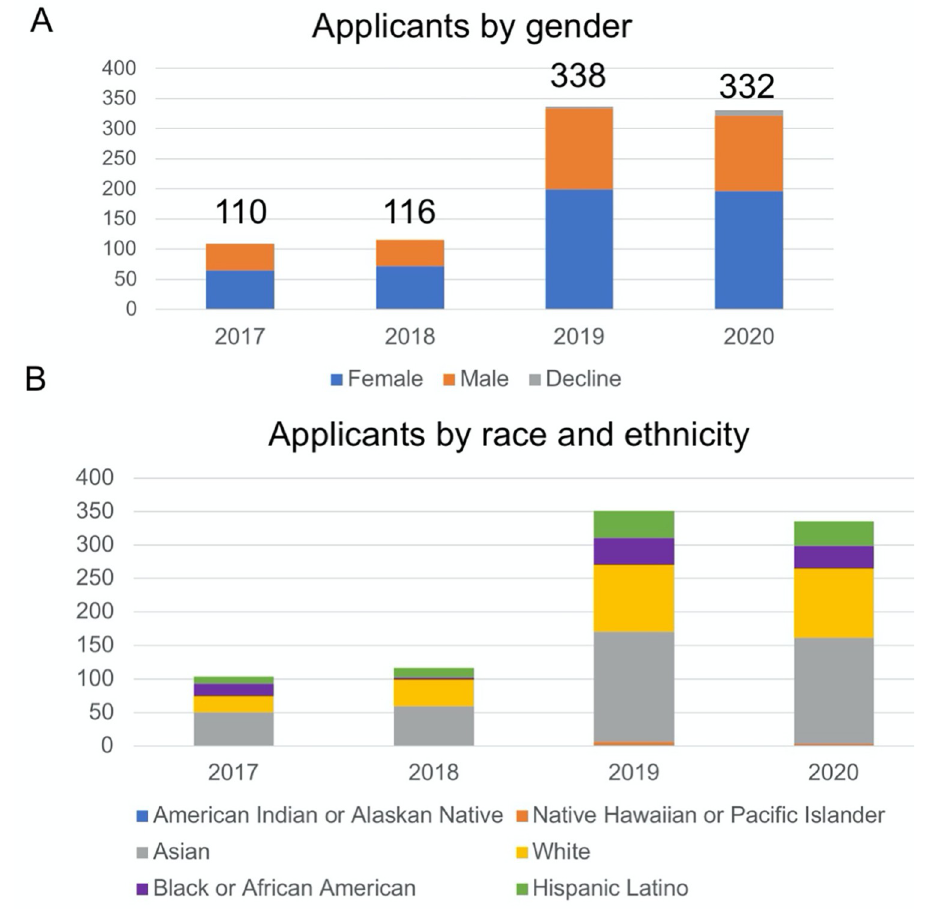
Fig 3. Applicants over time. (A) The number of applicants to the Bruins-in-Genomics Summer Program from 2017 to 2020 is plotted. Students are broken down by gender. (B) The number of applicants that categorized themselves into different race and ethnicity categories is plotted for 2017–2020. If applicants indicated multiple categories, they are included twice.